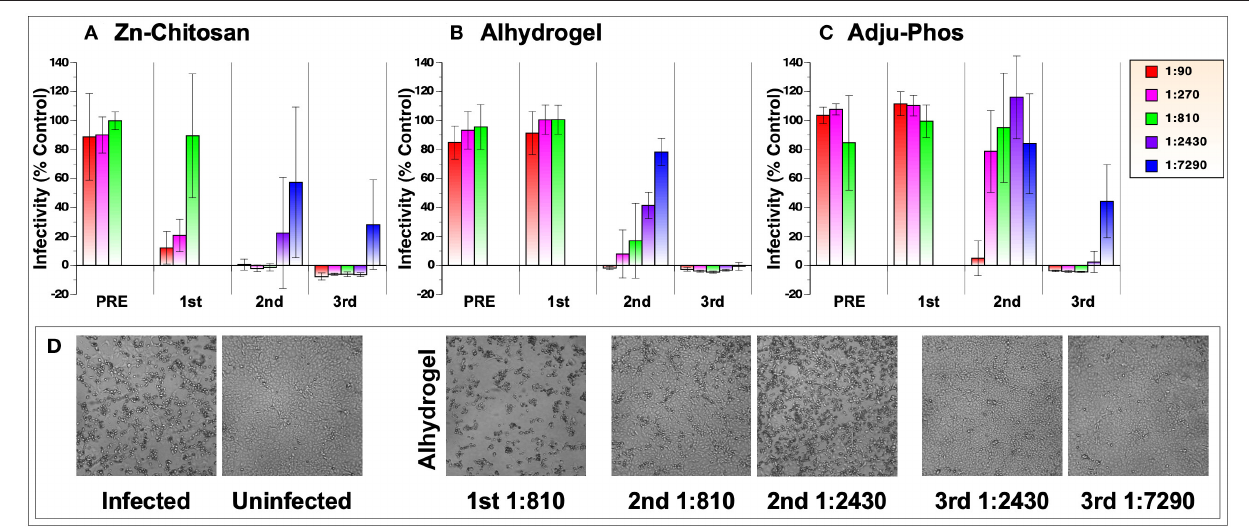
FIGURE 3 | SARS-CoV-2 neutralization assay. Vero E6 cells (2 × 10 4 cells/well) in 96-well-plates were infected with 50 pfu with various dilutions of pooled sera collected before (PRE) or after three immunizations (indicated as 1st, 2 nd , and 3rd). Virus infection was monitored by CyQuant LDH (lactate dehydrogenase) Cytotoxicity Assay, which measures the level of cytosolic LDH released into the culture medium when cells die from virus infection. The assay was done in triplicate. Results from three vaccine groups are shown: (A) Zn-chitosan, (B) Alhydrogel, and (C) Adju-Phos. (D) Brightfield photomicrographs of cell cultures from the neutralization assay. Results from the Alhydrogel group (for indicated immunizations and dilutions) are shown as